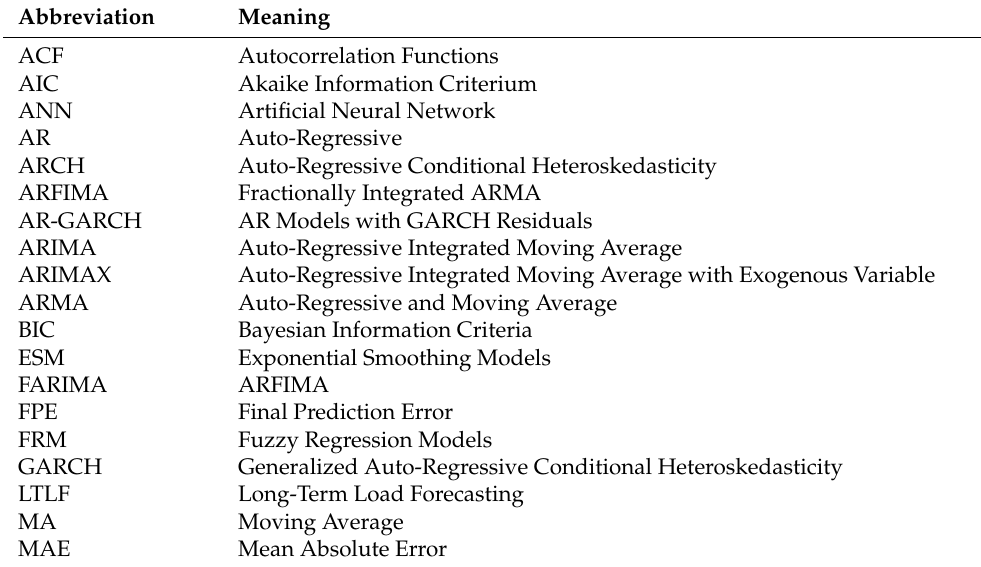
Table 1. List of abbreviations and acronyms used in this